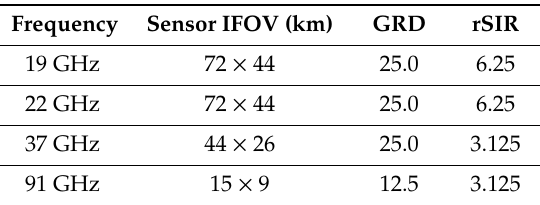
Table 1. Special Sensor Microwave Imager / Sounder (SSMIS) sensor instantaneous field of view (IFOV) (aka sensor footprint) and EASE2 grid spatial resolution for drop-in-the-bucket GRD and the radiometer Scatterometer Image Reconstruction (rSIR)